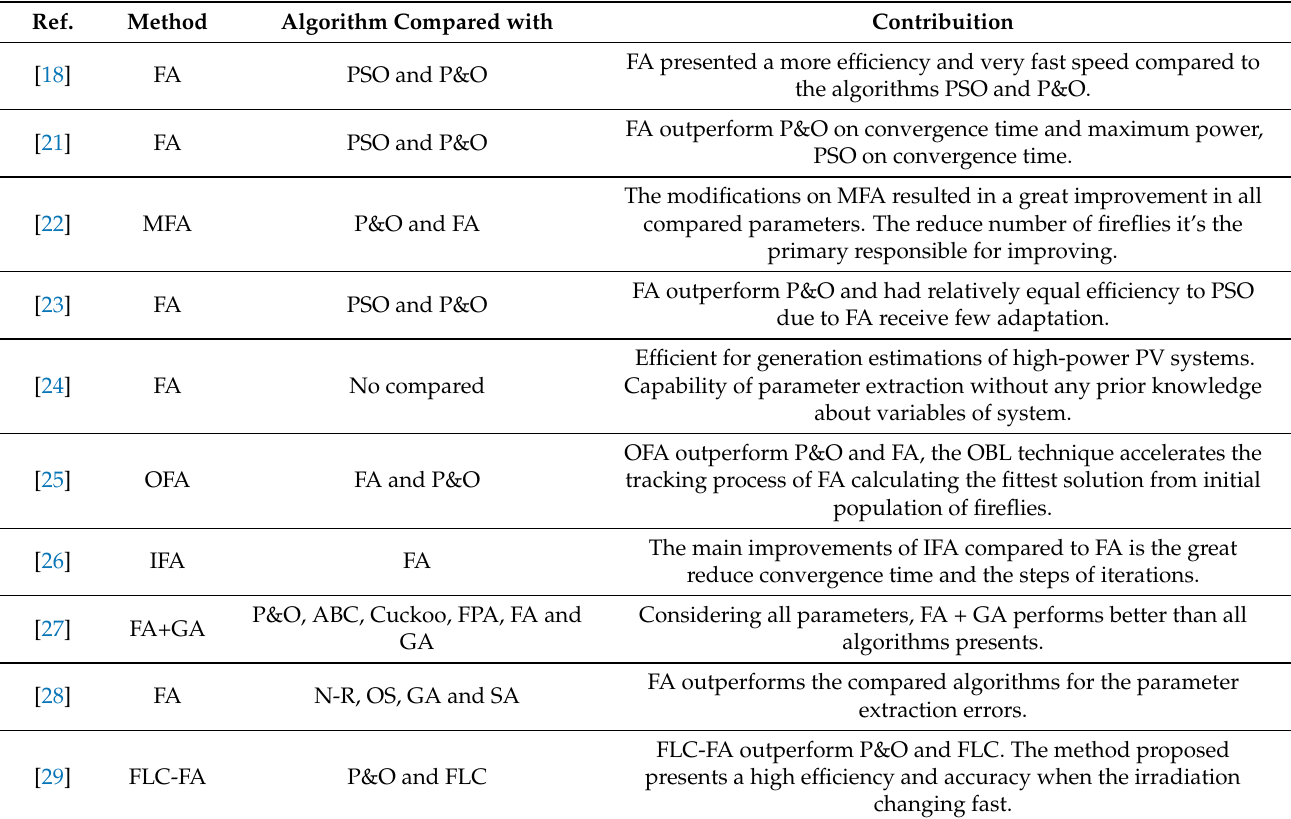
Table 3. Comparison with others methods MPPT